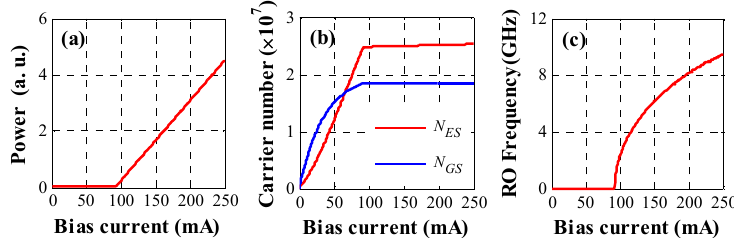
Figure 2. Output power ( a ), carrier number ( b ), and relaxation oscillation (RO) frequency ( c ) of the ES-QD laser as a function of the bias current.